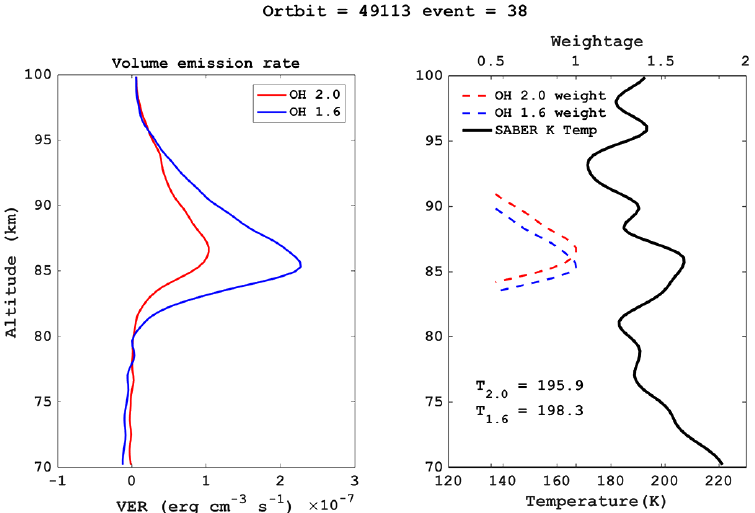
Figure 3. An illustration of estimation of OH-equivalent temperatures from SABER temperature profiles using OH 1.6 and 2.0µm VER profiles as the weighing function. (SABER measurements reference: Orbit 49113 Event 38 of 1 January 2011). The left panel presents OH 1.6 and 2.0µm VER profiles in the blue and red curves respectively. The blue and red broken curves in the right panel symbolize the weighing functions defined using OH 1.6 and 2.0µm VER profiles respectively. SABER temperature profile is shown by a solid curve in right panel.